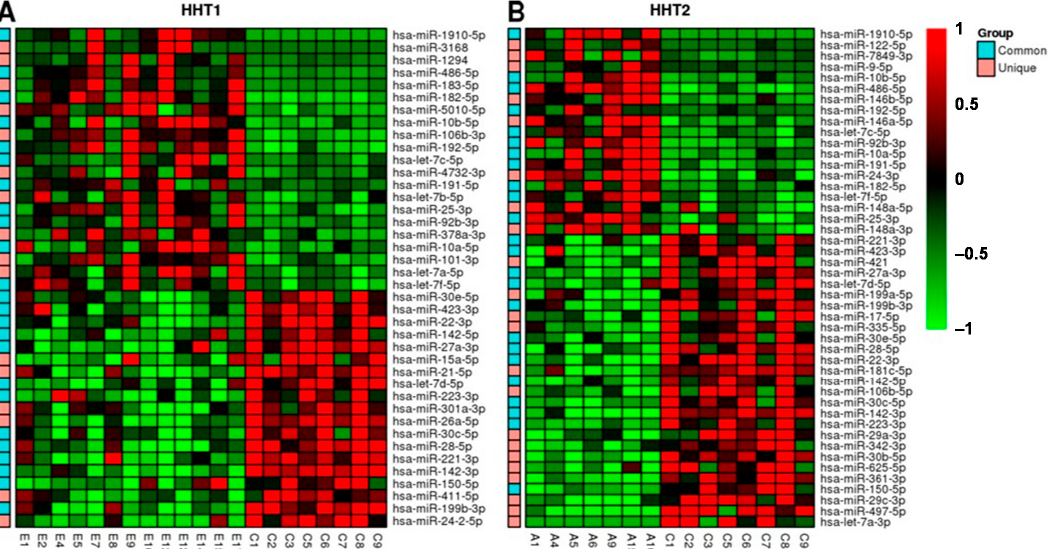
Figure 3. Heatmap showing the most differentially expressed miRNAs (adjusted p -value < 0.05) among ( A ) HHT1 subtype and healthy samples and ( B ) HHT2 subtype and healthy samples. MicroRNAs are in rows and individual samples are shown in columns, and their names refer to the corresponding experimental group: C, control; E, HHT1; and A, HHT2. Red and green colors represent upregulation and downregulation, respectively. The single left-hand column in each panel shows those miRNAs that were found significant in the comparison of all HHT samples versus healthy, marked as com- mon (cyan), while those that were found significant in each subtype are marked as unique (pink).